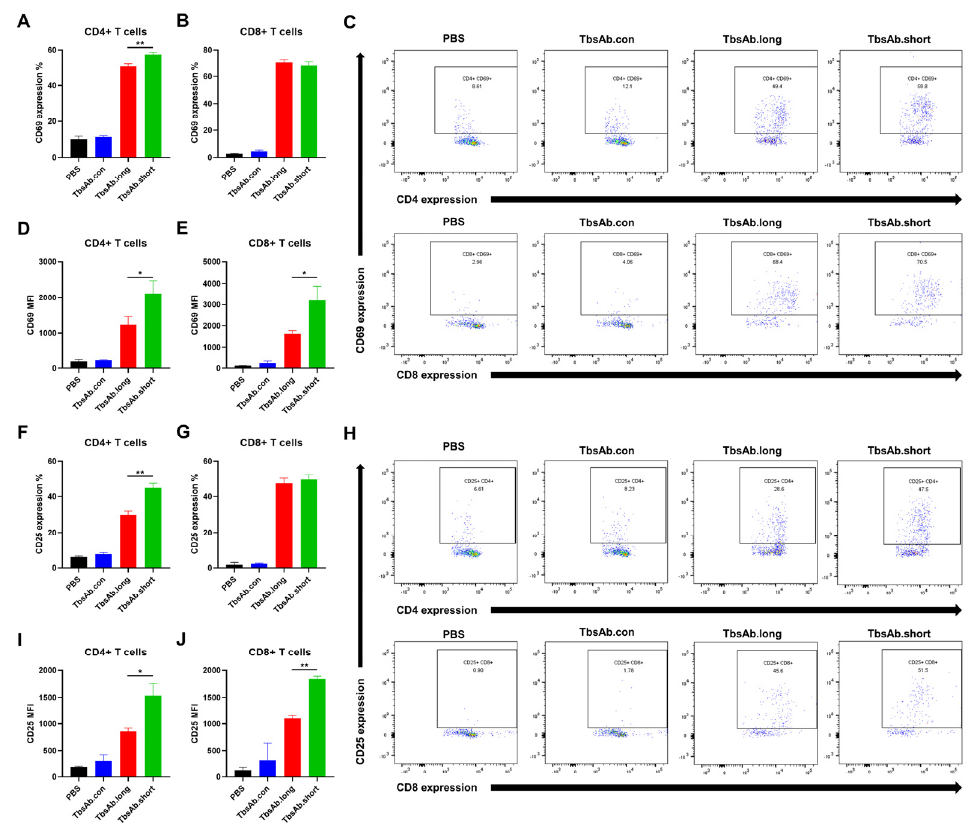
Figure 6. The TbsAb.short form induces superior T cell activation. ( A – E ) The expression level of CD69 on CD4+ and CD8+ T cells was detected after incubating with each TbsAb for 24 h (E:T = 5:1). ( F – J ) The expression level of CD25 on CD4+ and CD8+ T cells was detected after incubating with each TbsAb for 24 h (E:T = 5:1). *: p < 0.05; **: p <